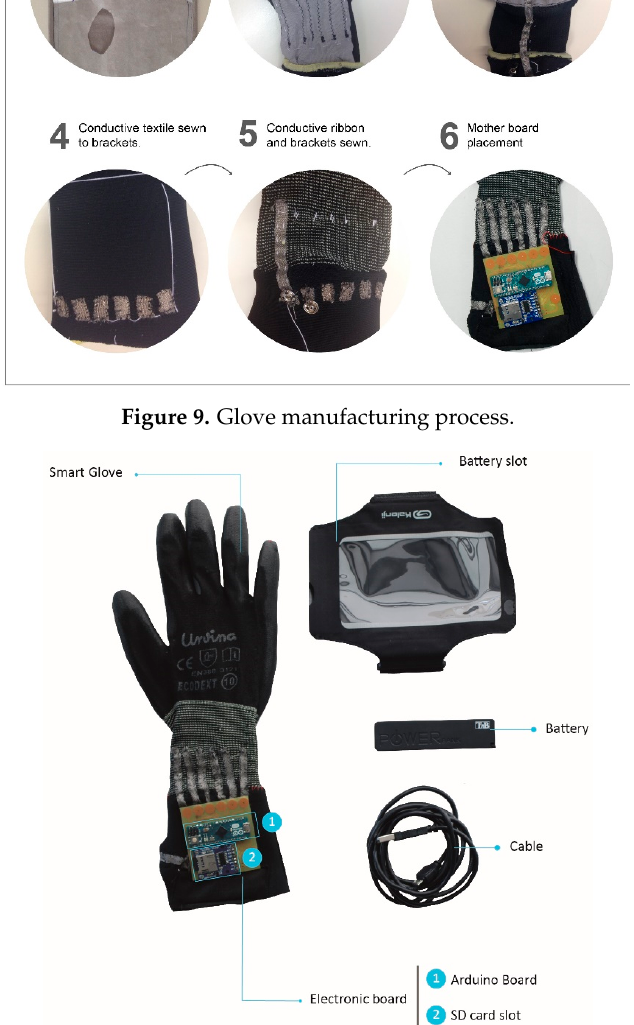
Figure 11. Prototype testing in a real rear door. The test consisted of two parts. In the first, all volunteers were asked to wear the glove and make some static movements to analyse the ergonomic feedback when wearing the glove [31]. After finishing the static movements, volunteers were asked to assemble some plastic pieces on the outside of a rear door of a vehicle. The movements that the volunteers performed for these operations were contact grip and distal compression as shown in Figure 11.